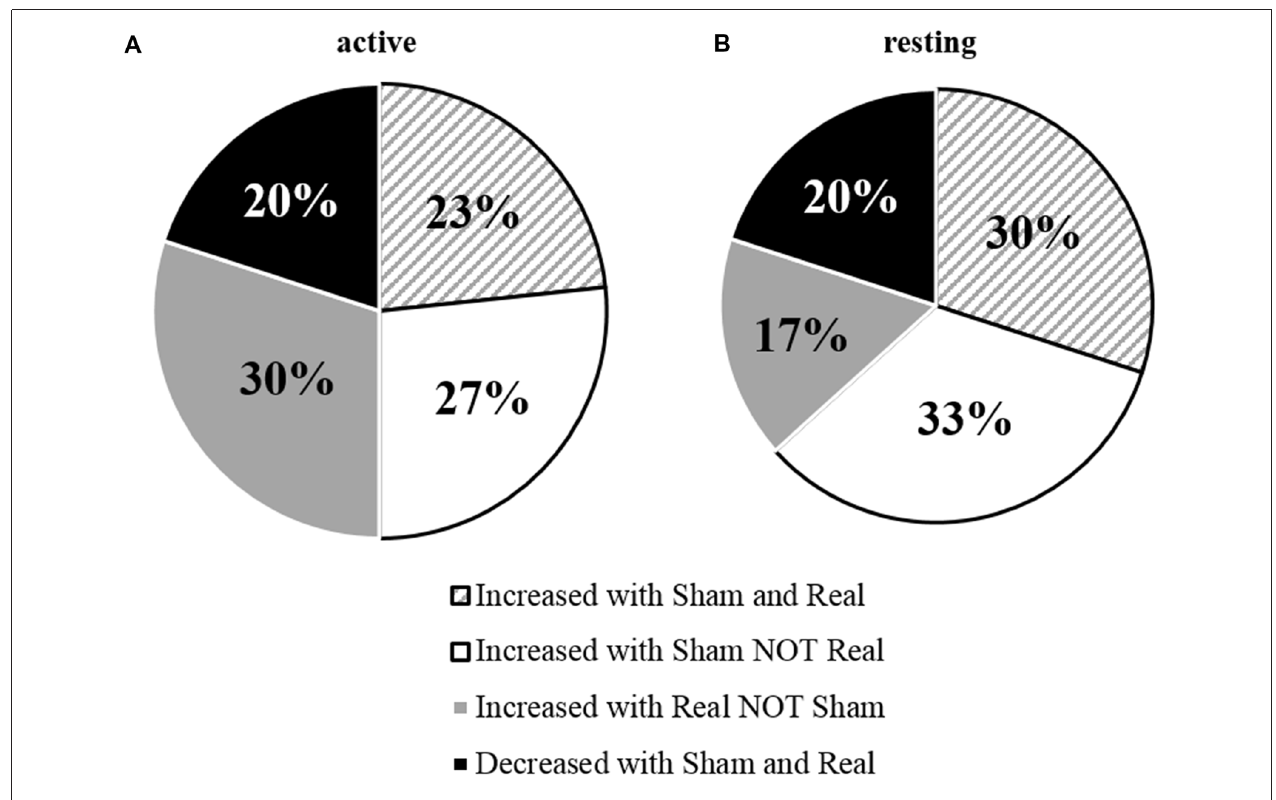
FIGURE 3 | Percentage of individual’s responses to tDCS measured under (A) active and (B) resting conditions.